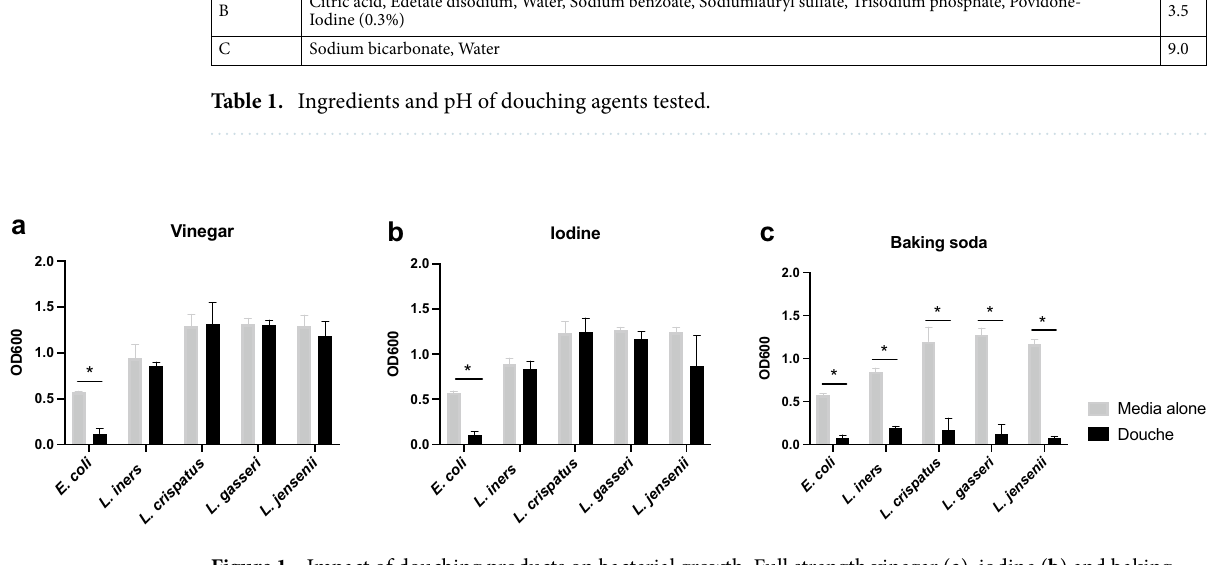
Figure 1. Impact of douching products on bacterial growth. Full strength vinegar ( a ), iodine ( b ) and baking soda-based ( c ) douching products were mixed 1:2 with broth culture of E. coli or one of four Lactobacillus species and growth compared by OD600 over 2 h ( E. coli ) or 24 h (lactobacilli). Results are presented as mean ± SD from at least two separate